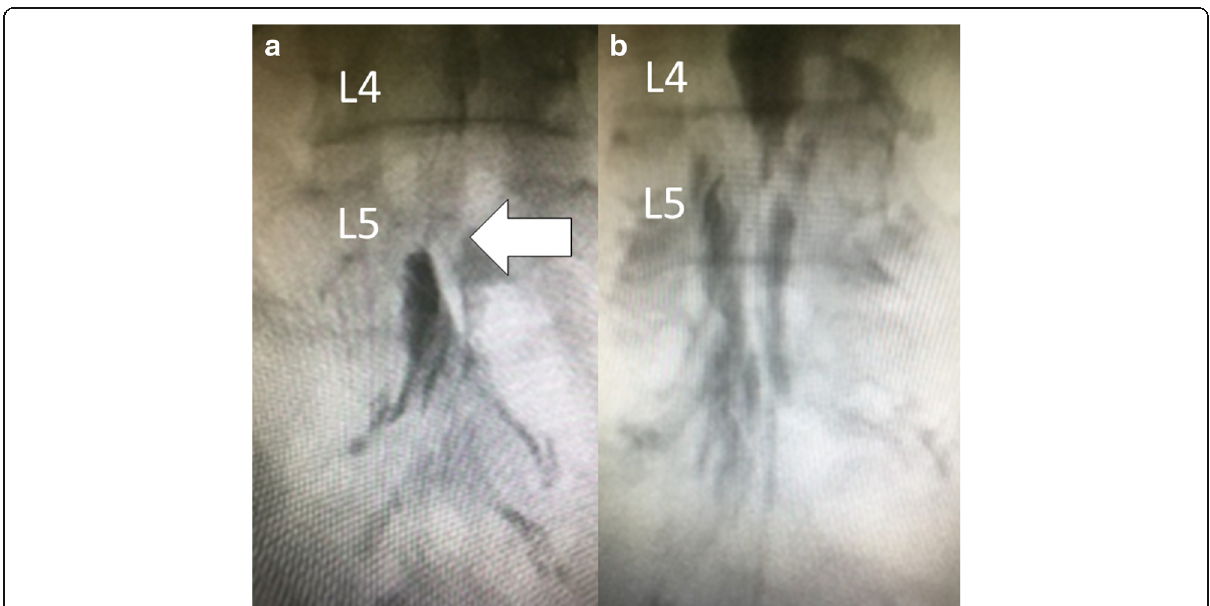
Fig. 2 Epidurography. a Before epiduroscopy, there was blockage of the L5/S1 vertebral area (arrow), with no contrast of the epidural space any further toward the cranial side of this area. b After epiduroscopy, contrast effects were achieved the cranial side of the epidural space from the L5 vertebral